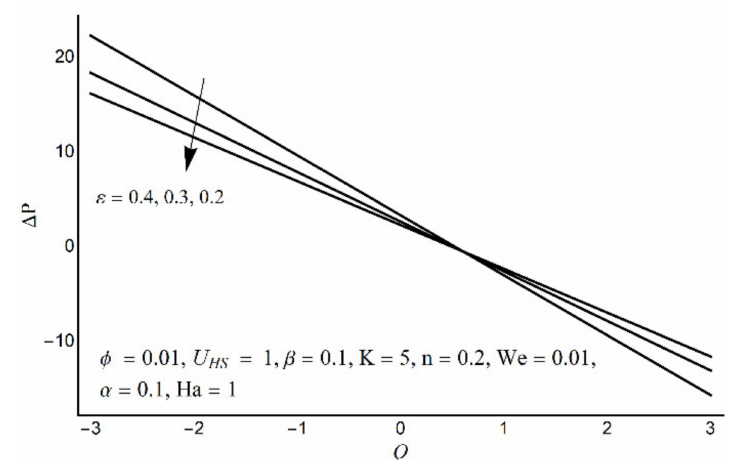
Figure 9. Pressure-rise per wavelength at varying ε .